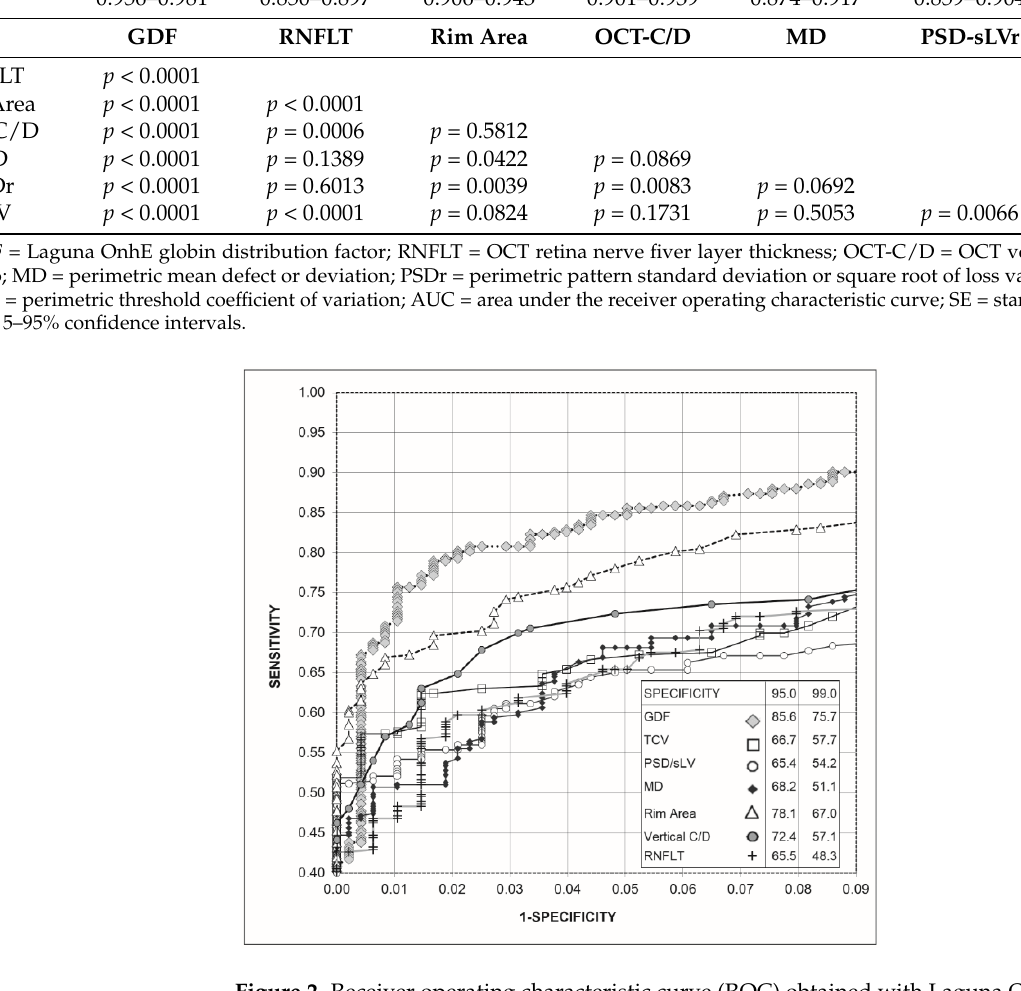
Table 1. Performance of Laguna OnhE, OCT, and perimetry indices.